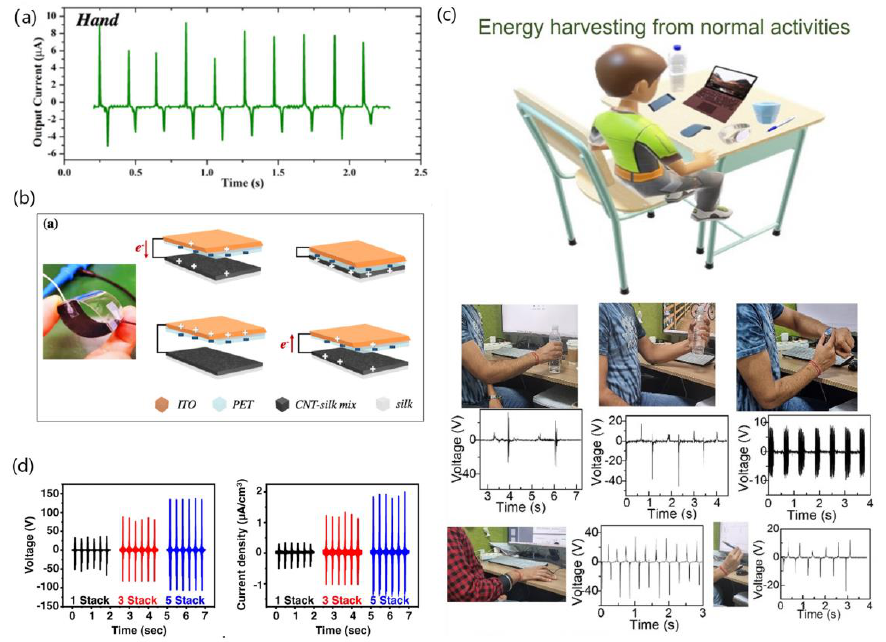
Figure 3. ( a ) The output voltage and current under shaker patting and hand patting [47]; ( b ) The optical image of the arch-shaped testing TENG and the schematic view of the working mode [47]; Copyright 2020, American Chemical Society; ( c ) Diagram of everyday activities from which power could be harvested and images of the corresponding output voltages Copyright 2022, American Chemical Society [48]; ( d ) Voltage output performance and current output performance of one− to five-stacked I-TENGs [49]; ( e ) Asynchronous TENGs and synchronous TENGs [49]; Copyright 2021, Nature Communications.